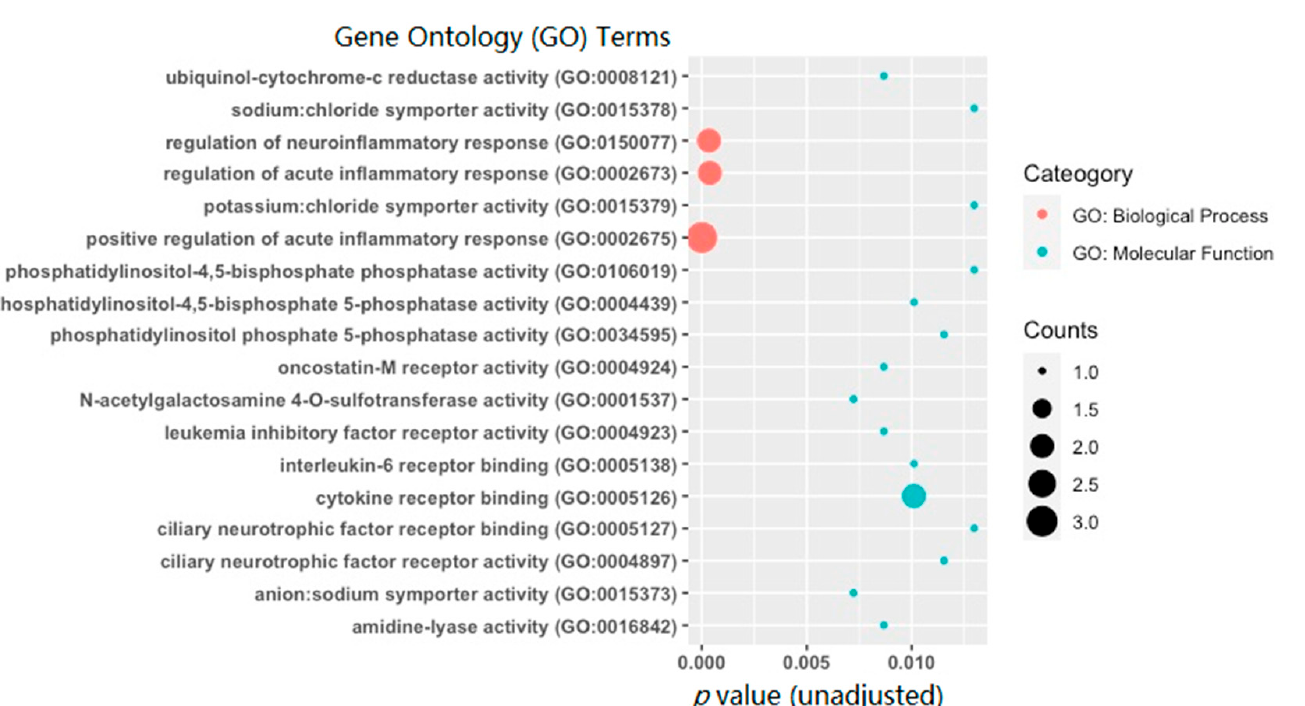
7 of 11 Figure 3. Heatmaps visualing differentially methylated mRNAs (n = 29), lncRNAs (n = 5), and miR- NAs (n = 3). The red–green gradient color scheme represents the high and low m6A-methylation levels as referenced in the Color Key. The top dendrogram shows the closeness among the samples. The sample group membership is indicated by the color bars above the heat map. 3.2. Gene Ontology (GO) Enrichment Analysis Results The top 18 Gene Ontology (GO) enrichment terms (adjusted p < 0.05) are shown in Figure 4. Among them, three were significant biological process (BP) terms, including Pos- itive Regulation of Acute Inflammatory Response (GO: 0002675; adjusted p = 4.5 × 10 − 4 ), Regu- lation of Neuroinflammatory Response (GO: 0150077; adjusted p = 0.046), and Regulation of Acute Inflammatory Response (GO: 0002673; adjusted p = 0.046). Other 15 were significant molecular function (MF) terms, including N-acetylgalactosamine 4-O-sulfotransferase activity (GO: 0001537; adjusted p = 0.048), Anion:Sodium Symporter Activity (GO: 0015373; adjusted p = 0.048), Oncostatin-M Receptor Activity (GO: 0004924; adjusted p = 0.048), Ubiquinol-cyto- chrome-c Reductase Activity (GO: 0008121; adjusted p = 0.048), Amidine-lyase Activity (GO: